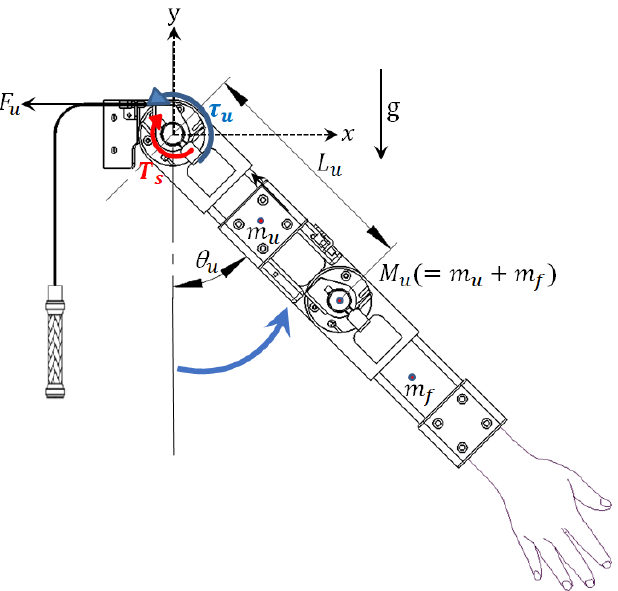
Figure 9. Dynamic model of the shoulder joint of the designed WURAES.